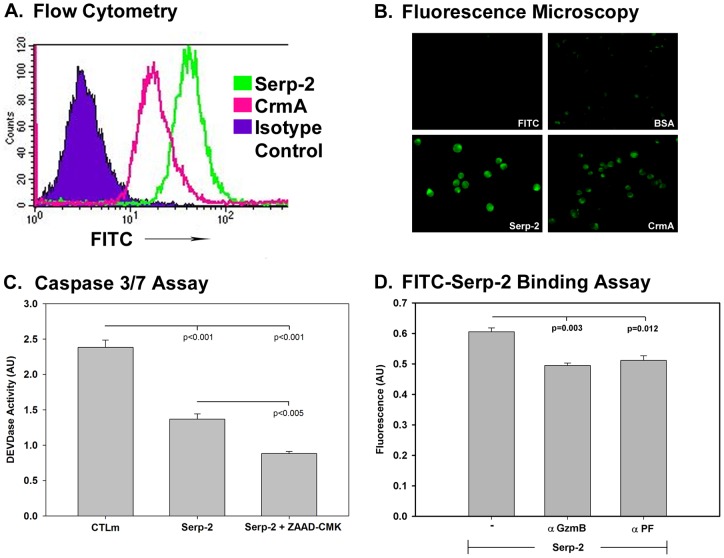
Serp-2 binds T cells in vitro with greater affinity than CrmA.Jurkat T cells were treated with FITC labeled Serp-2 or CrmA and binding/ association of these viral proteins with T cells was analyzed using Flow cytometry (FACS) analysis (A) and fluorescence microscopy (B, Magnification 10X). Extracellular, surface FACS analysis shows both Serp-2 and CrmA bind to the T cell surface (A). This observation was also supported by the fluorescent microscopic analysis (B). Intracellular ZAAD-CMK granzyme B inhibitor decreased Serp-2 mediated inhibition of caspase 3 activity in response to treatment with CTLm (cytotoxic-like T cell medium) (C, p<0.005). Treatment with antibody to granzyme B (α GzmB) or perforin (α PF) partially blocked Serp-2 binding (D, p<0.003 and p<0.012, respectively). The results represent mean ± SE from 3 to 5 replicates for each experiment. Significance was assessed by analysis of variance (ANOVA) with secondary Fishers least significant difference and Mann Whitney analysis.